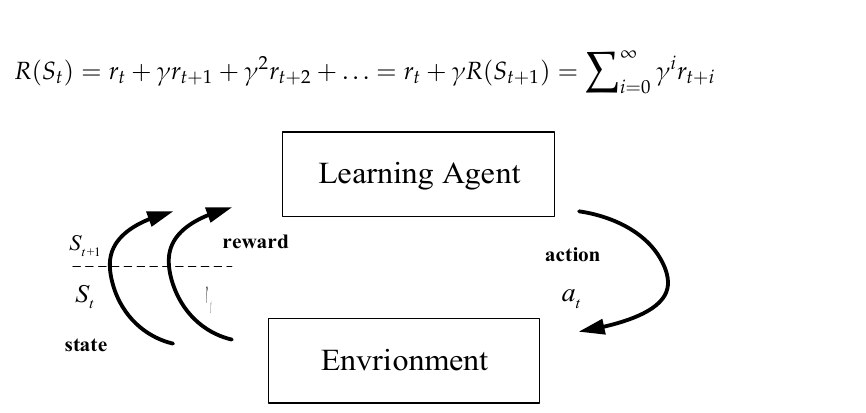
Figure 1. Reinforcement learning architecture.